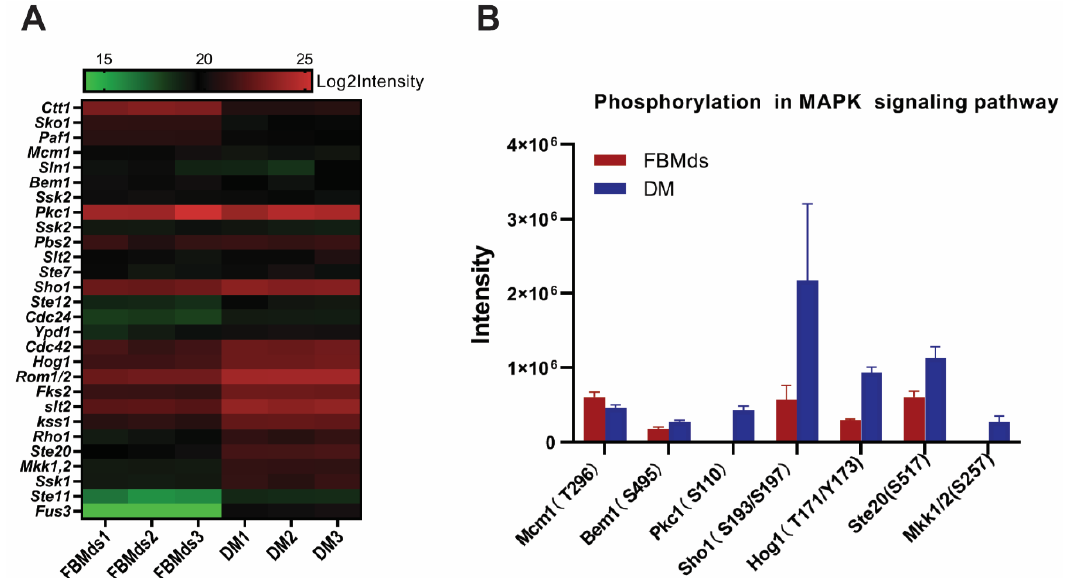
Figure 5. Protein expression and phosphorylation level of Mitogen-activated protein kinase (MAPK) signaling pathway. ( A ) Heatmap of proteins in MAPK signaling pathway between FBMds and DM: the protein names on the left are homologous with Saccharomyces cerevisiae. ( B ) Column chart of phosphorylation site intensity of MAPK signaling pathways in FBMds and DM, respectively.